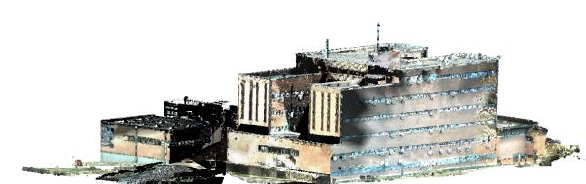
Figure 10. Outdoor point cloud of the educational building.